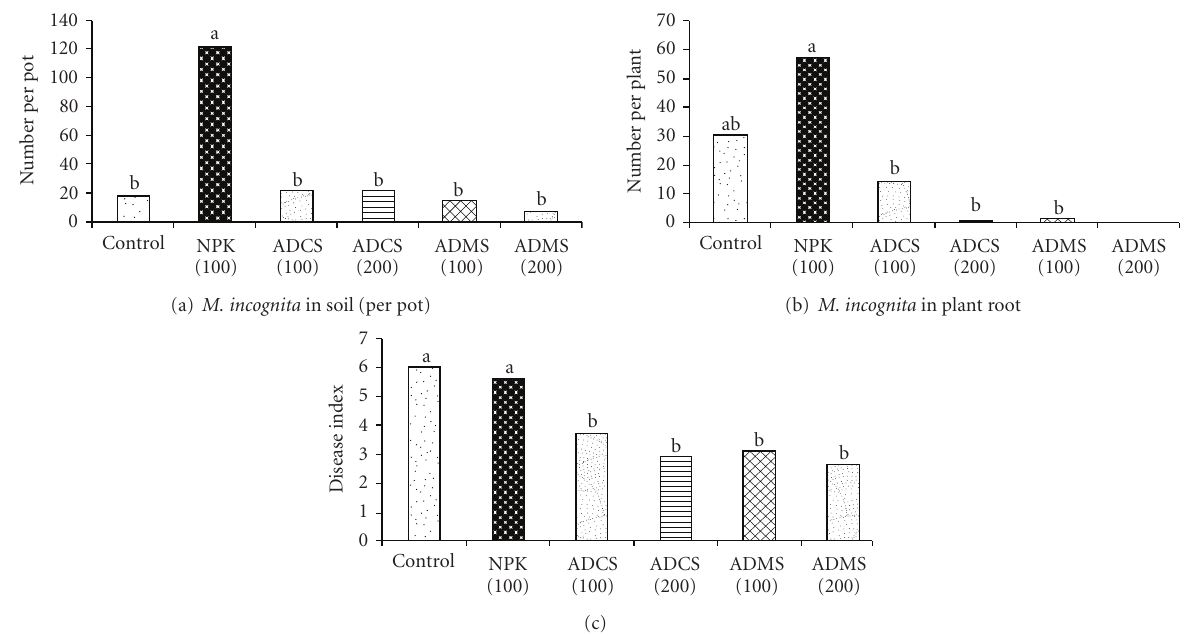
Figure 1: Population of Meloidogyne incognita in soil (a) and tomato roots (b) at one month after application of anaerobically digested slurry and root-knot gall index (c). Di ff erent letters indicate significant di ff erences between the treatments at P < . 05. NPK: chemical fertilizer (8:8: 8 N :P: K), ADCS: cow slurry, ADMS: municipal biowastes and excess slurry, 100: 100 mgNH 4+ -N kg − 1 soil and 200: 200mgNH 4+ - N kg − 1